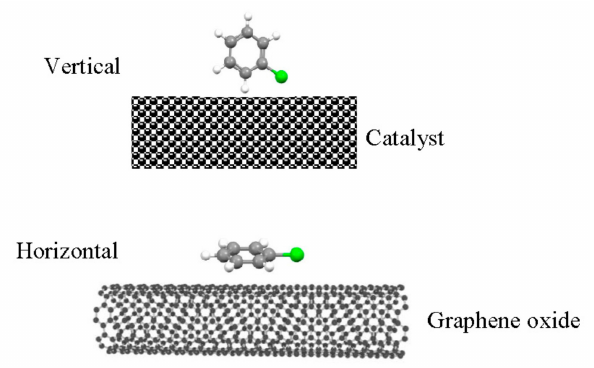
Figure 11. The adsorption model on the catalyst